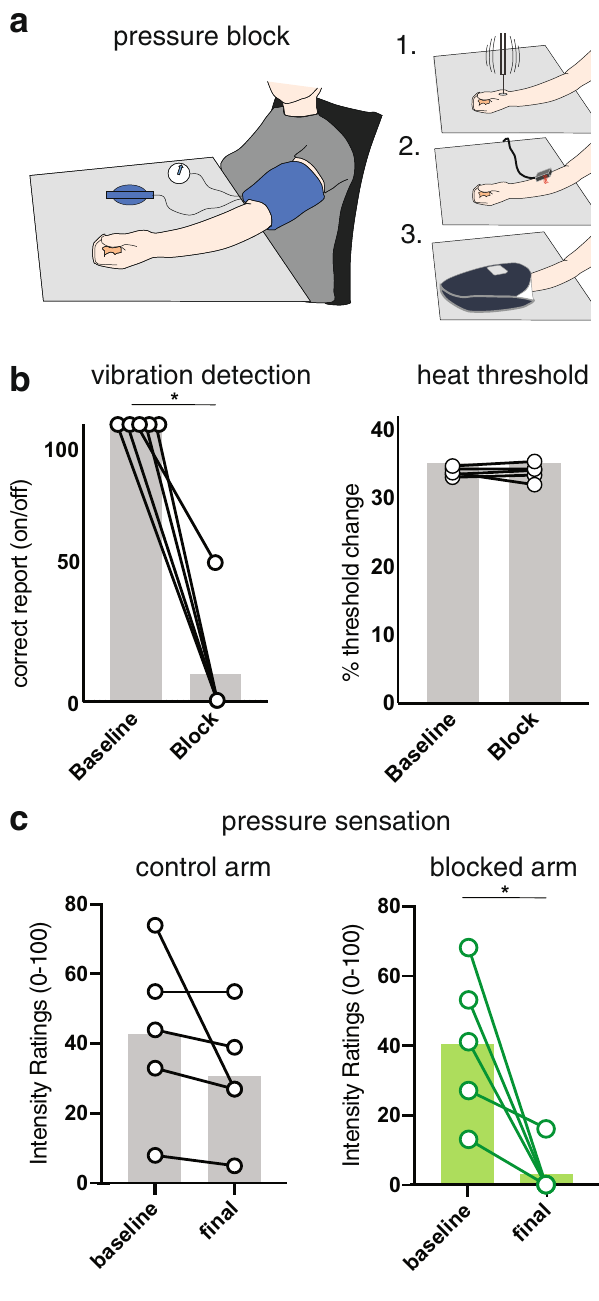
Fig. 1 A β - fi ber blockade inhibits innocuous pressure sensation in the hand. a A cartoon depicting the administration of a pressure block during quantitative sensory evaluation. A blood pressure cuff was placed on the upper arm of fi ve healthy adult volunteers and in fl ated to ~100 mmHg above the participant ’ s systolic blood pressure. Repeated tests of